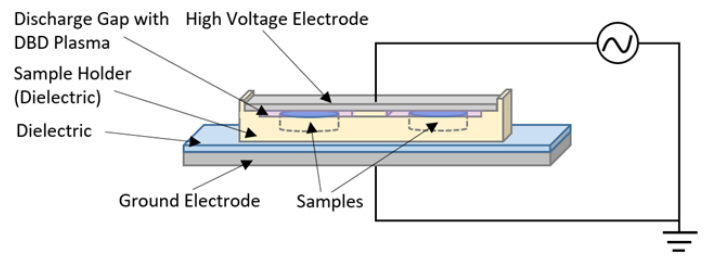
Figure 1. Schematic of the setup used for plasma